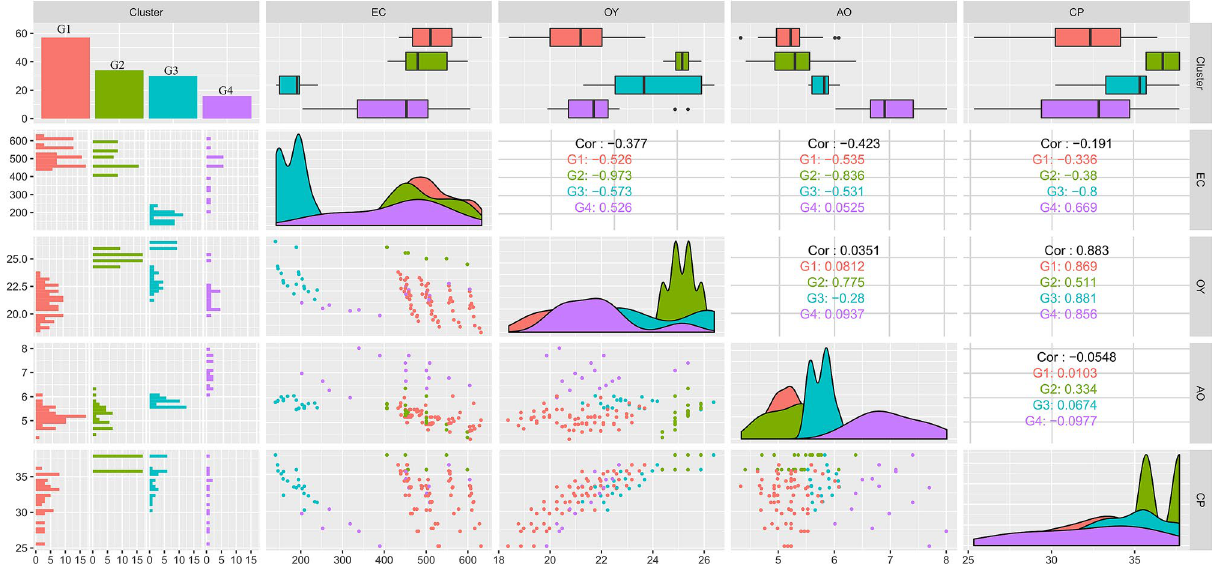
Figure 5. Dispersion and Pearson’s correlation between the variables evaluated according to the groups defined by the cluster